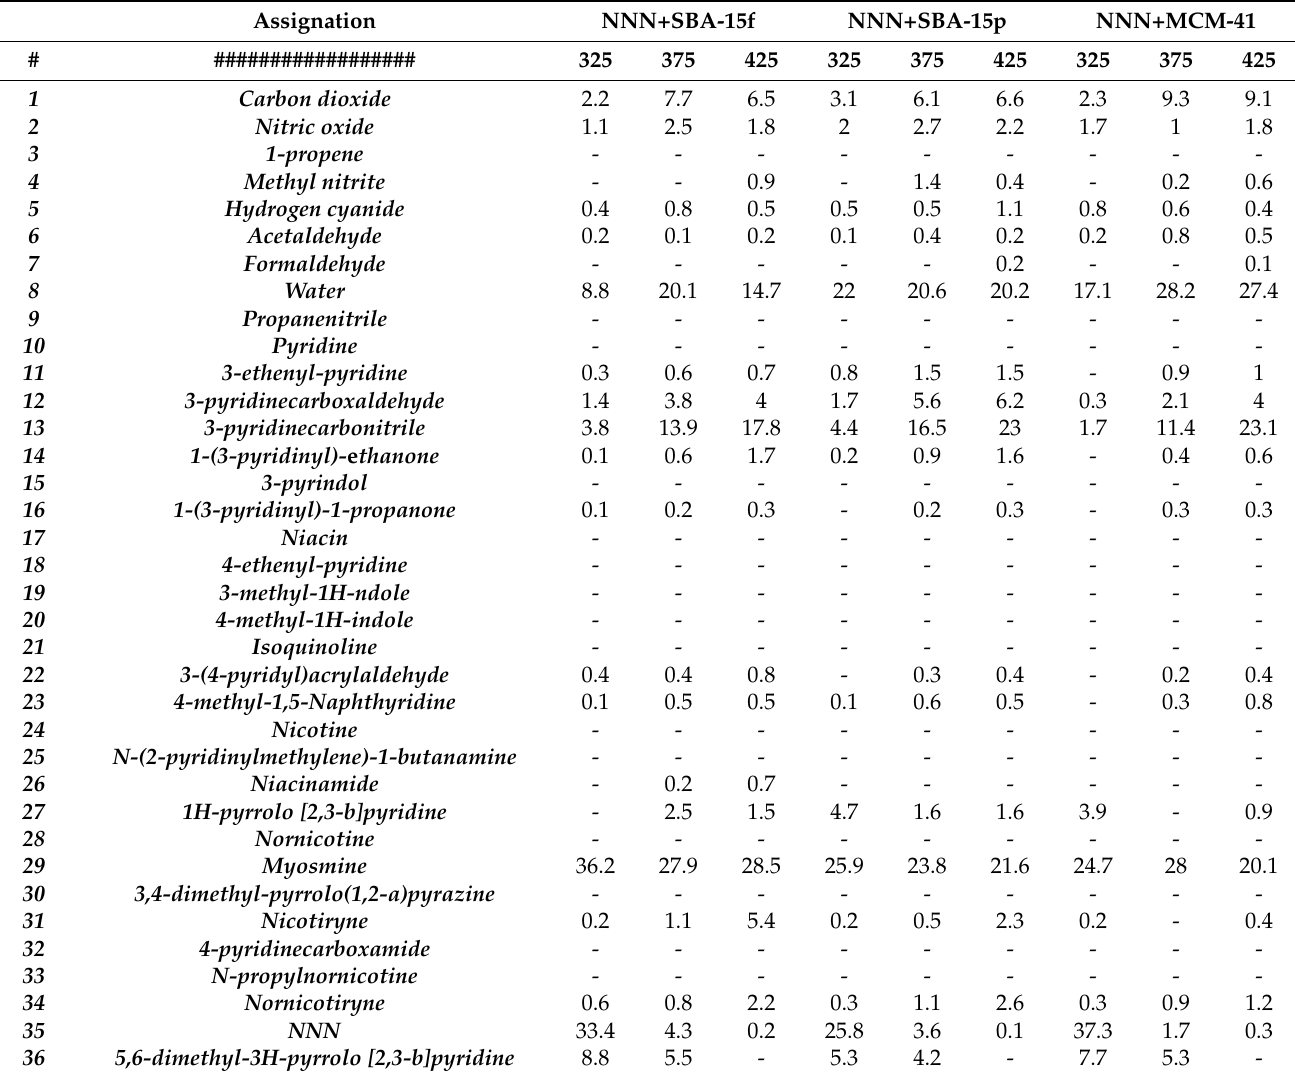
Table A3. Contribution of total area (%) of assigned compounds in the catalyst pyrolysis of NNN with three catalyst under the air atmosphere at different temperatures ( ◦